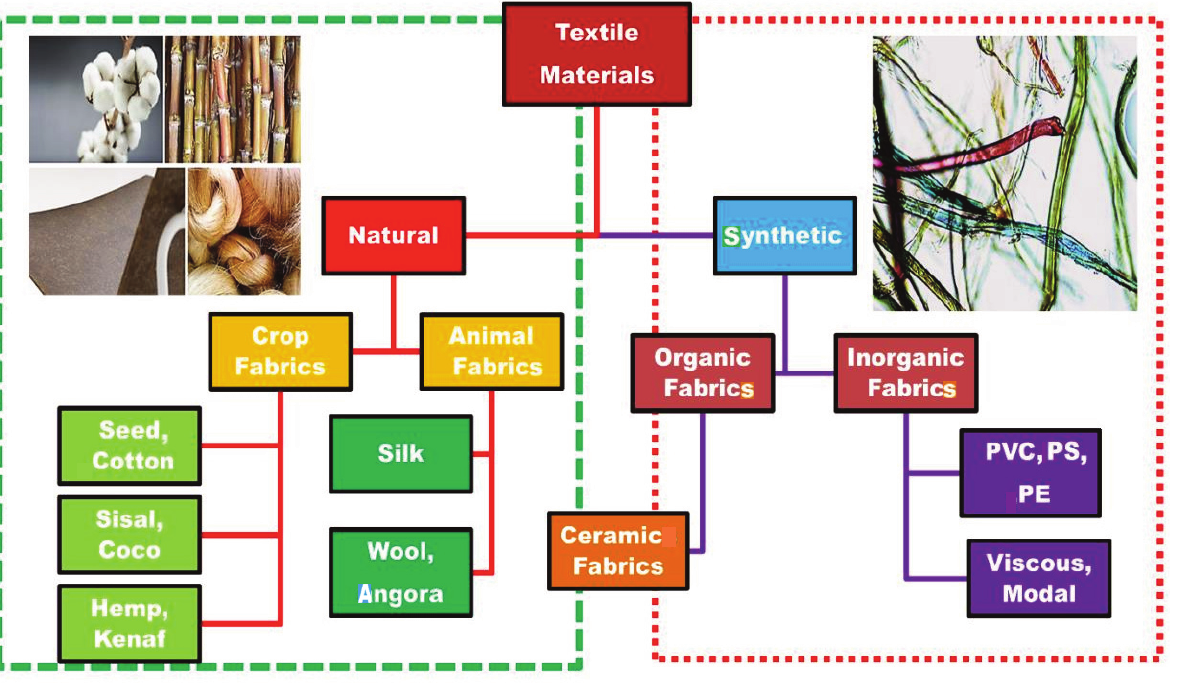
Fig. 3. Types of commercial textile materials. !